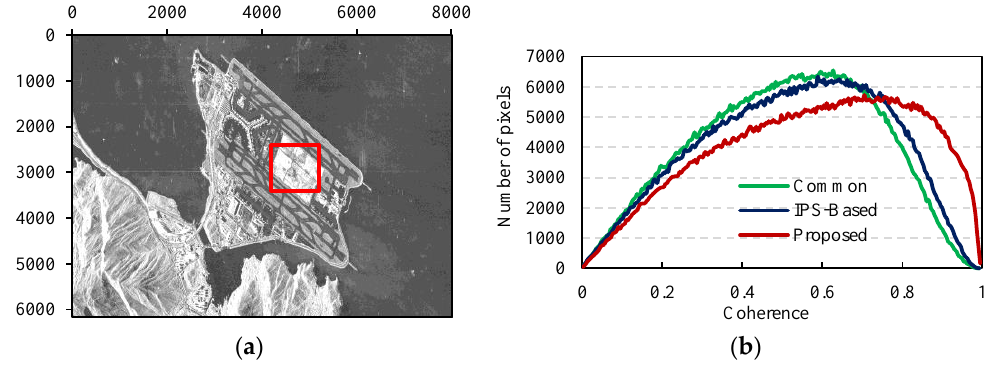
Figure 10. Coherence analysis. ( a ) Land region (red square) for coherence estimation; and ( b ) the coherence histograms by the three methods.